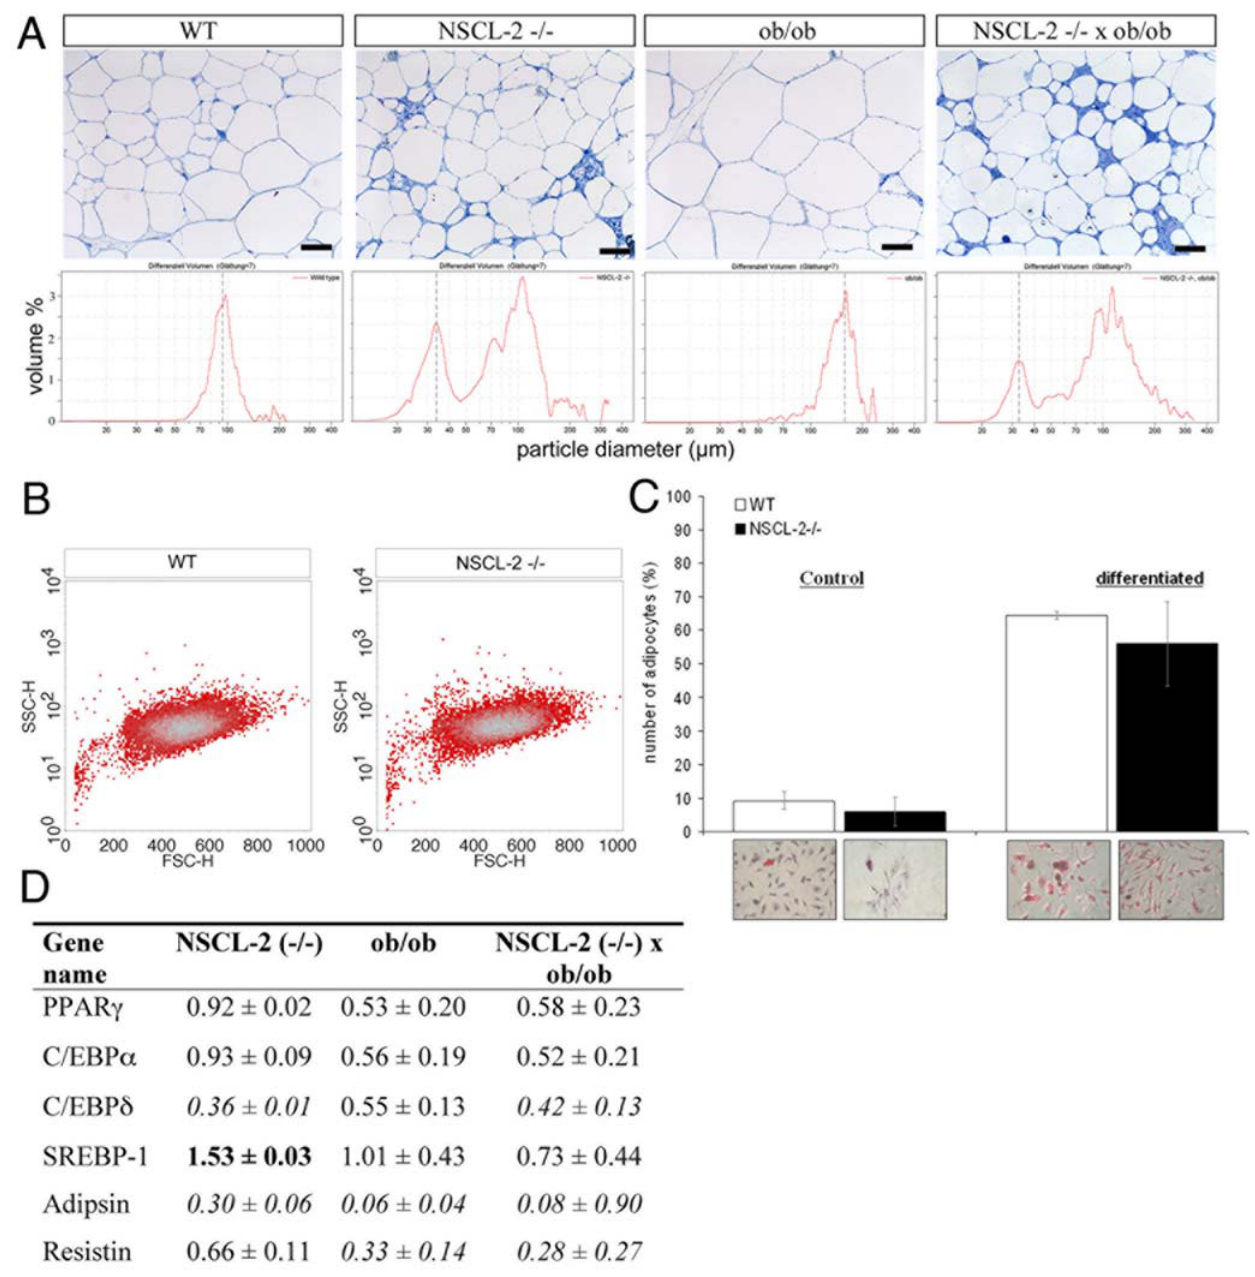
Figure 6. Bimodal distribution of adipocytes in Nscl-2 ( 2 / 2 ) mice and normal invitro differentiation of isolated Nscl-2 mutant preadipocytes. (A) Semithin sections (Richardson stain) of epididymal adipose tissue from 6 month old male animals. Histograms indicate the size distribution of isolated adipocytes from different strains. Scale bars: 100 m m. (B) FACS analysis (sideward versus forward scatter) of preadipocytes after 1 day in culture reveals a general uniformity in cell size and granularity. (C) Normal in vitro differentiation of isolated Nscl-2 mutant preadipocytes. Differentiated, lipid drop containing cells were identified by oil red staining. (D) Relative mRNA expression level of adipocyte differentiation related genes and adipocytokines expressed in epididymal WAT determined by quantitative Real-Time PCR (mean values, n $ 3). Values in bold indicate changes . 150% compared to controls, values in italic indicate changes , 50% of compared to controls. Relative expression level=(GeneX mutant / 36B4 mutant )/ (GeneX WT /36B4 WT